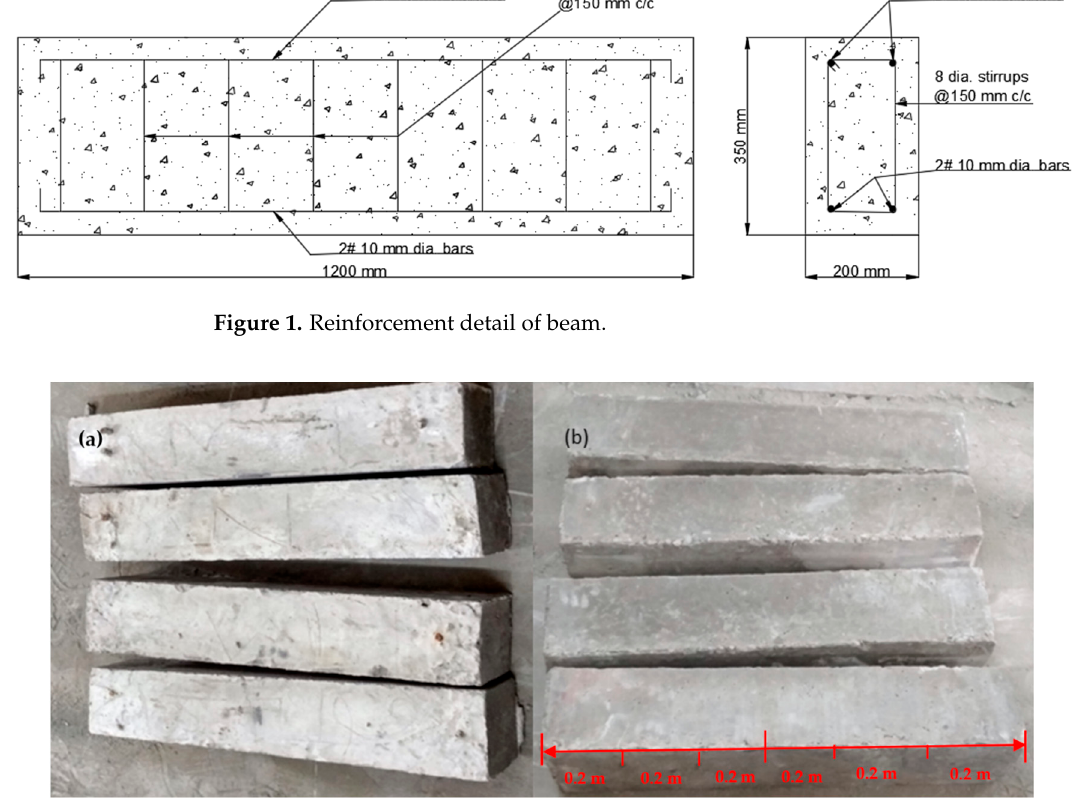
Figure 2. ( a , b ) Prepared beam specimens without CFRP sheets.